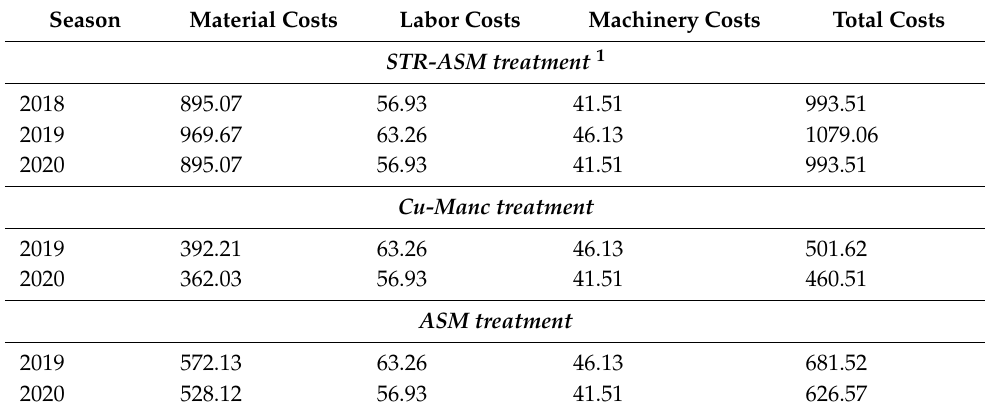
Table 2. Average application costs for each bactericide treatment in USD/ha by season.